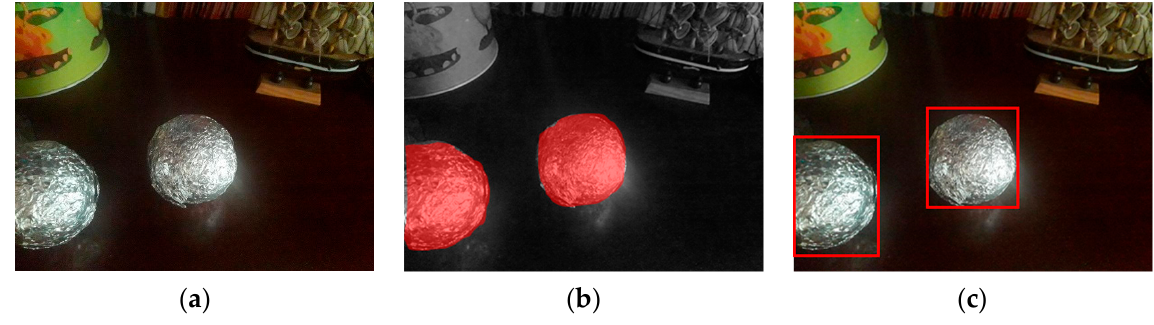
Figure 4. Annotation of images: ( a ) input (original) image, ( b ) annotation for semantic segmentation (red pixels) and ( c ) annotation for object detection (red bounding box).